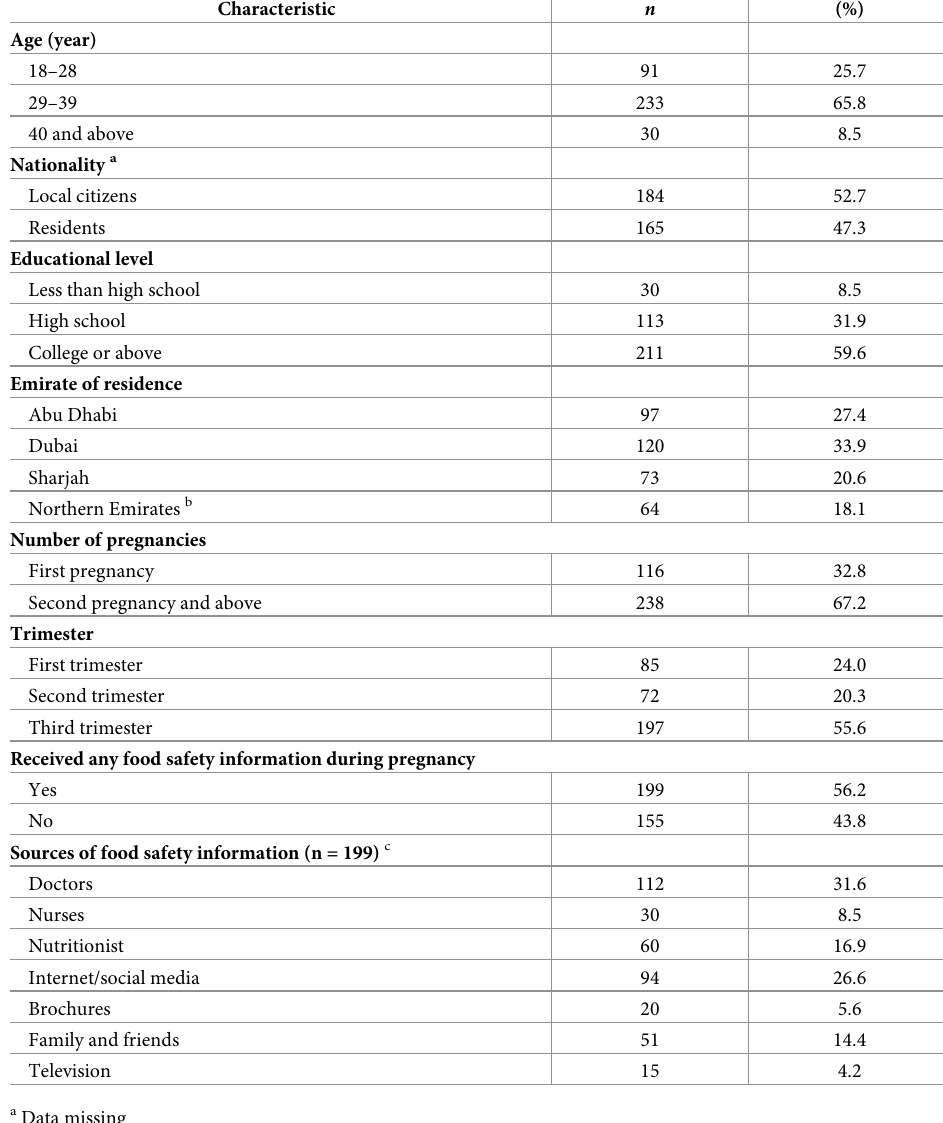
Table 1. Sociodemographic characteristics of the study participants (n =